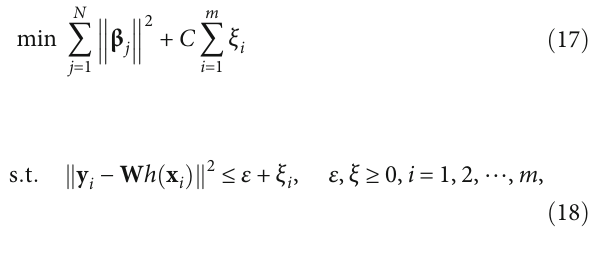
algorithm form of information transmission using